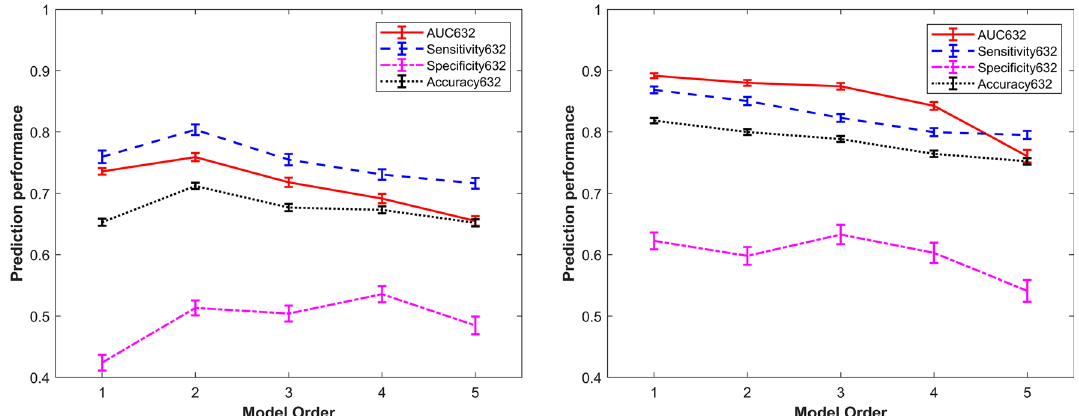
Figure 5. Prediction performances of models from order 1 to 5 for detection of PCa in PI-RADS 3 lesions (on the left) and in upPI-RADS 4 lesions (on the